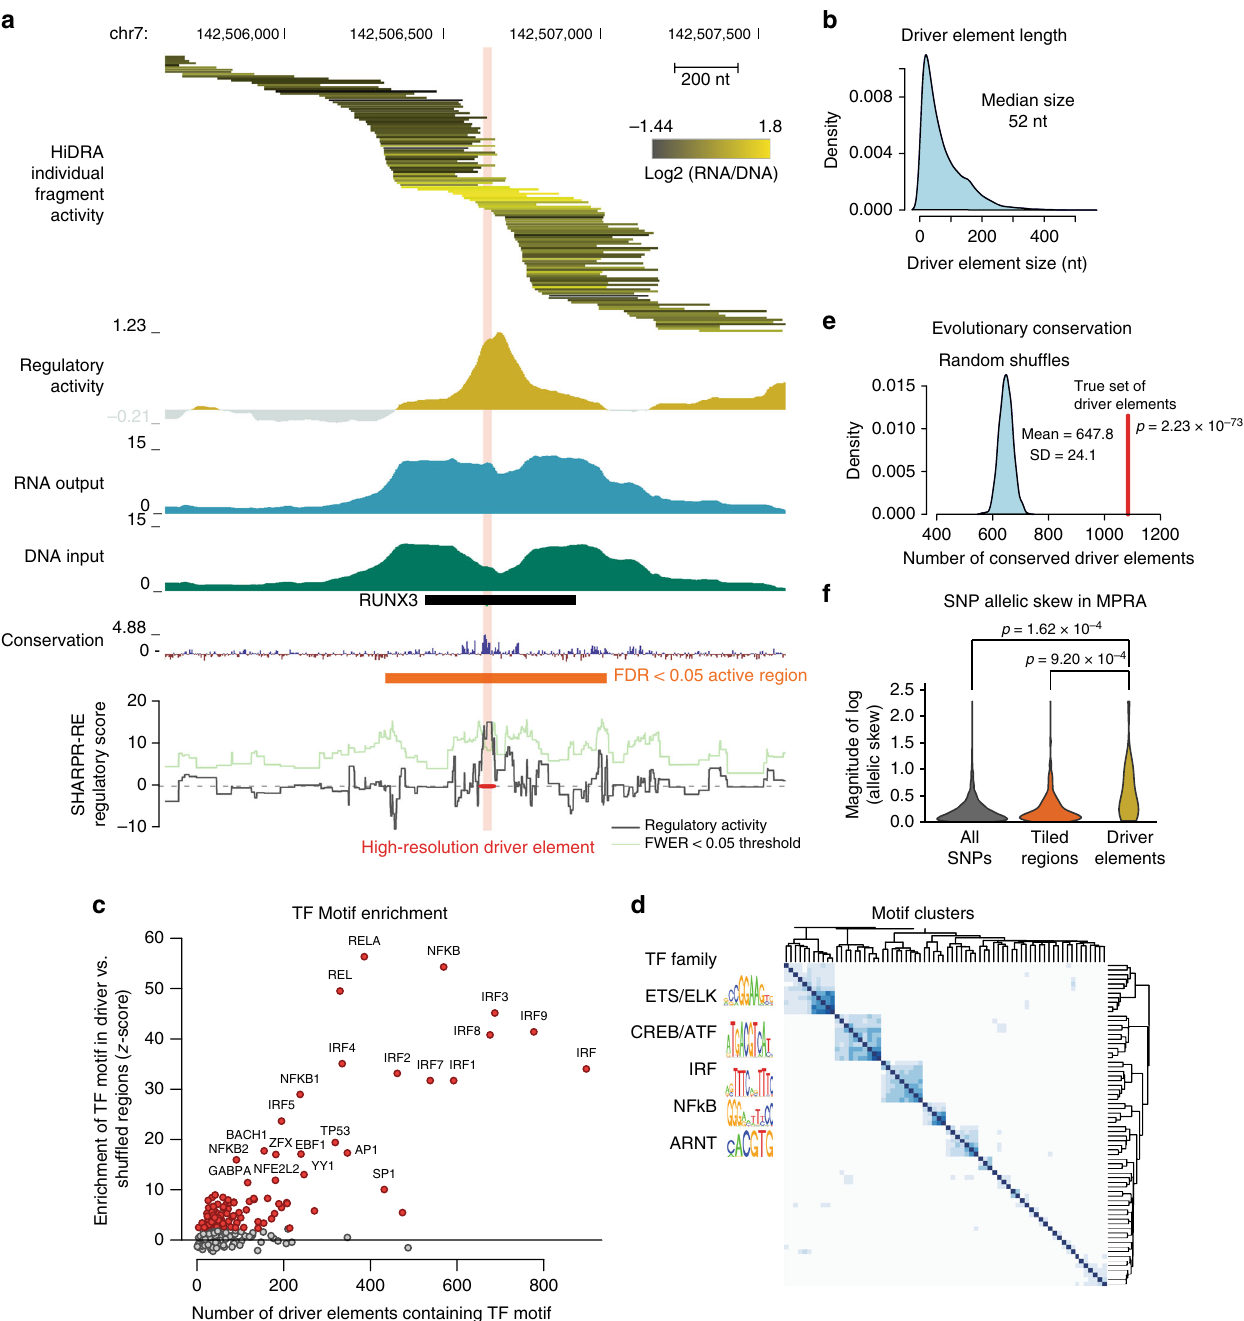
Fig. 4 High-resolution mapping of transcriptional regulatory elements with SHARPR-RE. a Example region used in high-resolution mapping. Fragment activity shown on log2 scale with two fragments with highest and lowest activity removed for color scale to avoid outliers. The transparent red bar indicates the driver element identi fi ed at the regional FWER < 0.05. b Size distribution of driver elements. c Enrichment of immune-related TF motifs in driver elements compared with shuf fl ed driver elements within tiled regions. d TF motifs enriched in driver elements cluster into groups of co-occurring motifs, suggesting diversity of TF motifs involved in transcriptional regulatory activity. e Signi fi cantly more driver elements are evolutionary conserved compared to shuf fl ed driver elements within tiled regions. Evolutionary conservation cut-off chosen as conservation score for top 5% of shuf fl ed regions ( p = 2.23 x 10 – 73 vs. Gaussian distribution estimated by random shuf fl ing of driver element positions in tiled regions). f SNPs within driver elements have signi fi cantly greater allelic skew by MPRA (Tewhey et al. 27 ) compared with those within tiled regions or across the genome. P value calculated by Mann-Whitney U